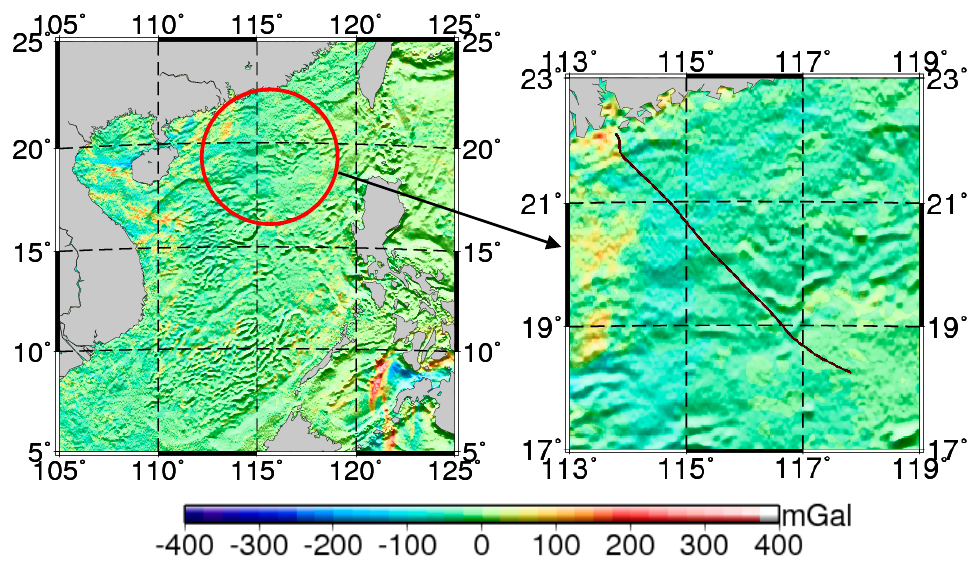
Figure 2. Ship-measured gravity areas and tracks.